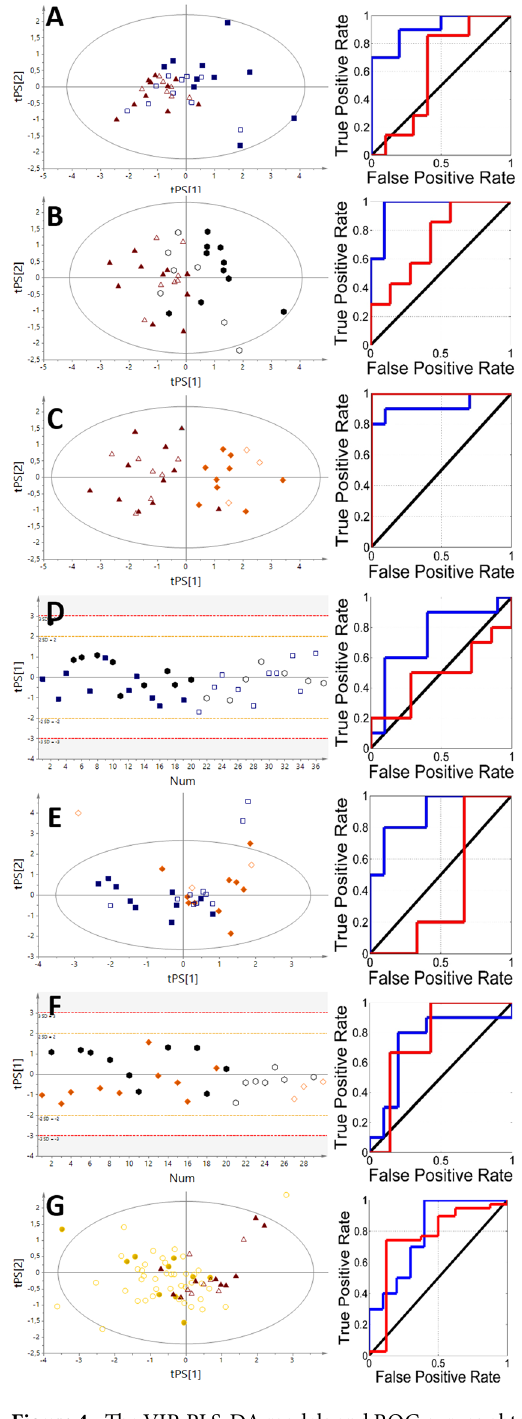
Figure 4. The VIP-PLS-DA models and ROC curves obtained from the urine samples. ( A) – NN vs HC; ( B) – FA vs HC; ( C) – TC vs HC; ( D) – TC vs NN; ( E) – FA vs NN; ( F) – FA vs TC; ( G) – P vs HC. Red triangles – healthy control; blue boxes – non-neoplastic nodules; yellow diamonds – follicular adenoma; black hexagons – papillary thyroid cancer; gold circles – patients. Solid symbols: training set; empty symbols: predicted test